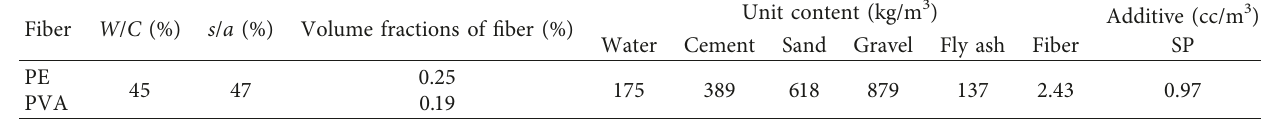
Table 1: Mix proportion of fiber concrete.